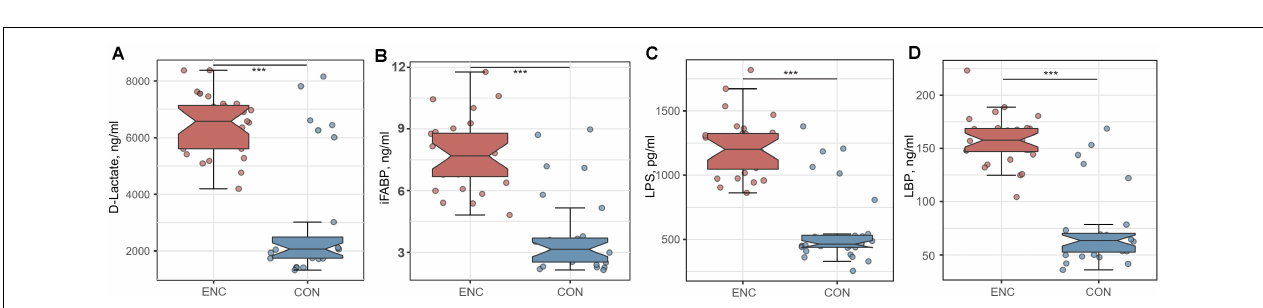
FIGURE 4 | Comparison of six fecal SCFA levels between encephalitis patients and healthy controls. (A) acetate; (B) propionate; (C) butyrate; (D) isobutyrate; (E) valerate; (F) isovalerate. * p < 0.05; ** p < 0.01; *** p < 0.001; Mann-Whitney U test. ENC, patients with encephalitis; CON, healthy subjects serving as controls.